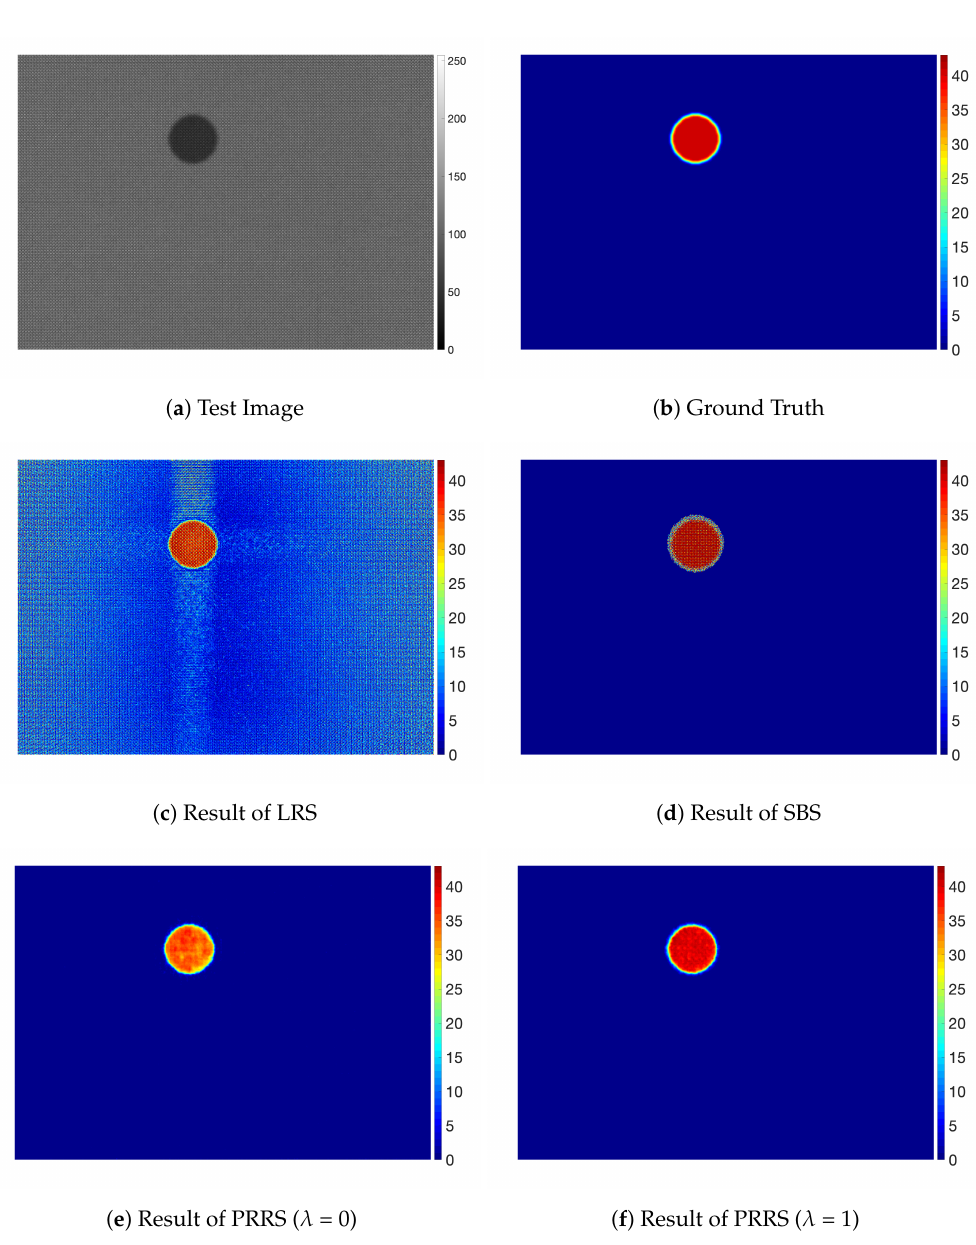
Figure 7. Examples of display panel images with faint dot type.